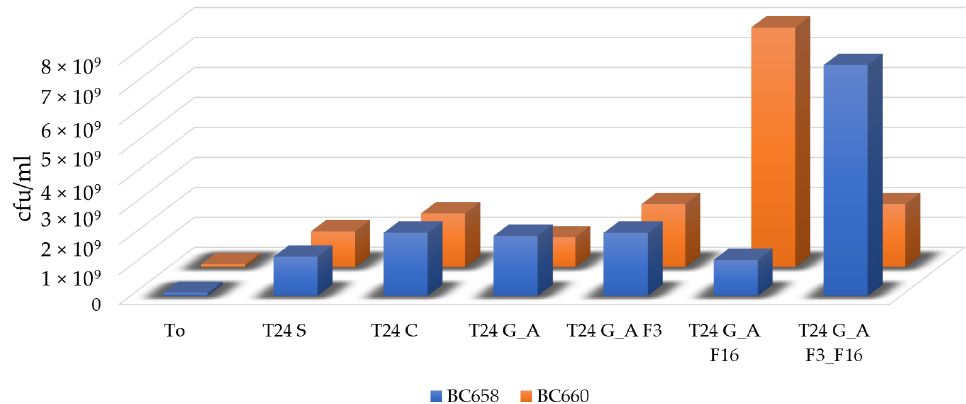
Figure 17. Histogram showing the increase in OD 550 of the bacterial suspensions before the experi- ment and after. No significant differences were found between the control suspensions (no glasses, T 24S, and untreated glasses T 24C ) and the microbial suspensions coming from the Petri dishes with treated glasses.